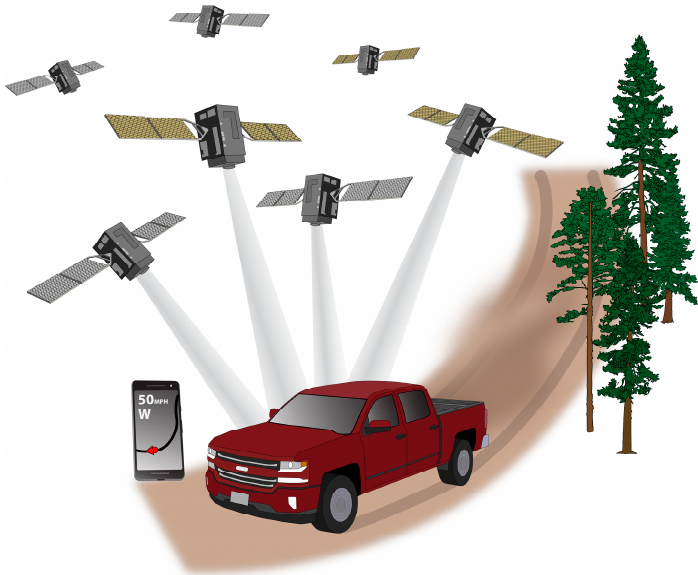
Figure 1. The Global Positioning System (GPS) and, more broadly, the Global Navigation Satellite System (GNSS), rely on three or more navigation satellites to determine ground position of receivers. Position is determined based on the time-delay associated with signal reception relative to synchronized clocks on each satellite. GNSS devices with the capacity to integrate signals from two or more international constellations are increasingly available. The rapidly growing number of satellites generally corresponds with increasing accuracy in a wider range of devices over a 5–10 year transition period.